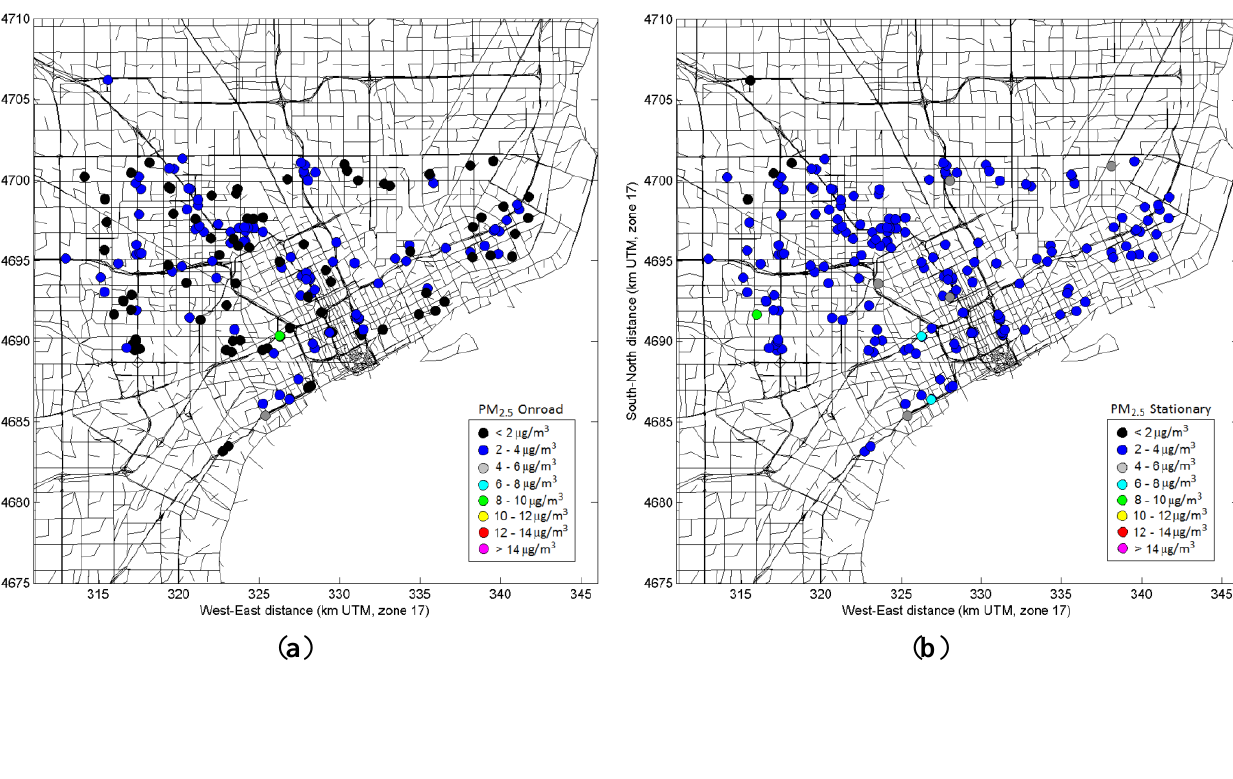
concentrations averaged during 2.5